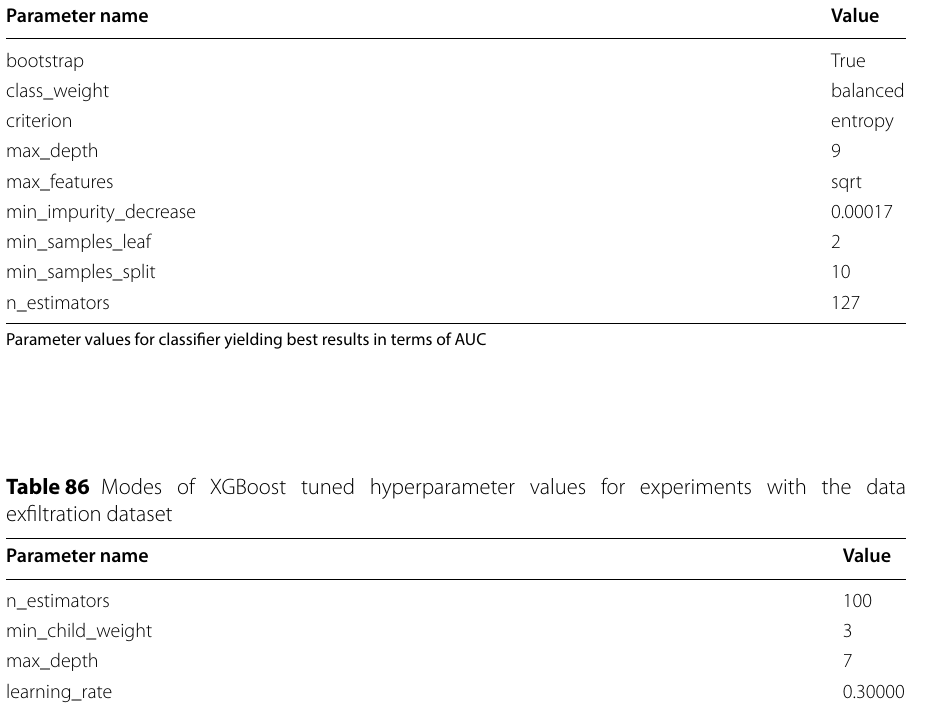
Table 85 Modes of RF tuned hyperparameter values for experiments with the data exfiltration dataset